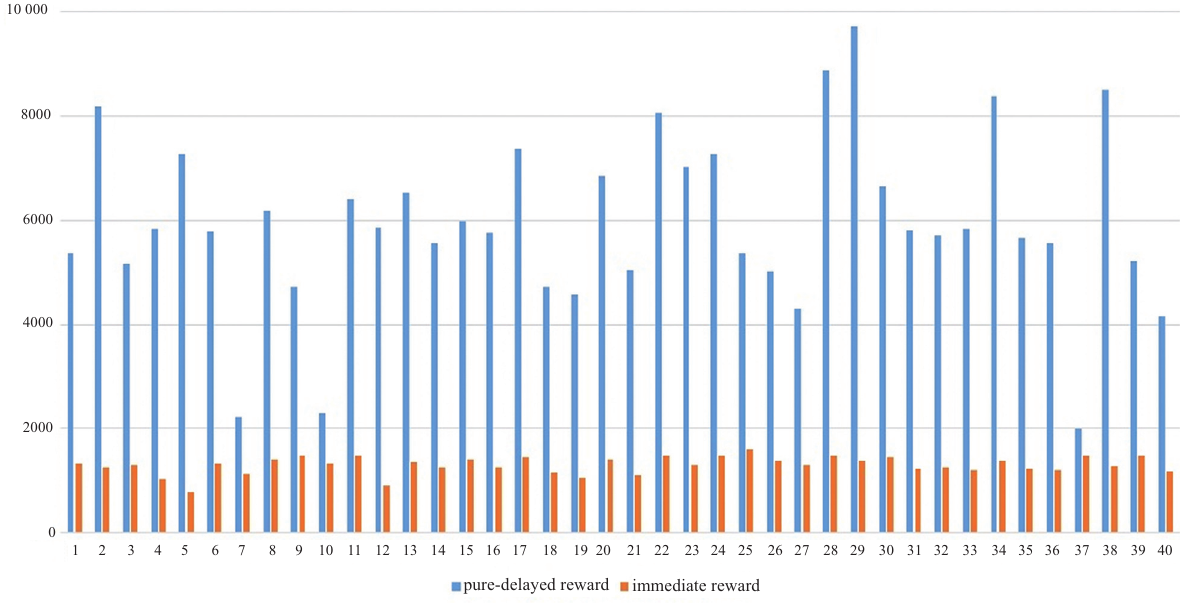
Fig. 4. Distribution of the number of training steps for two reward schemes when 𝑛 = 8.